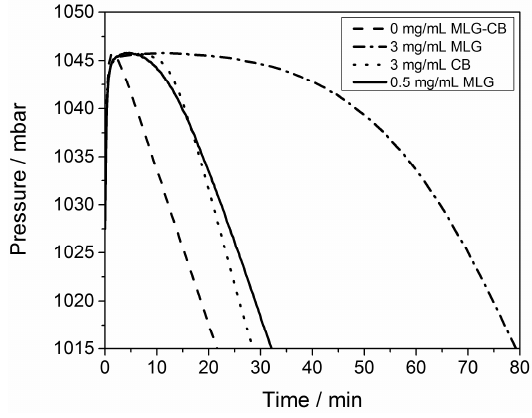
Figure 3. Change in pressure during the cumene oxidation with and without MLG or CB.